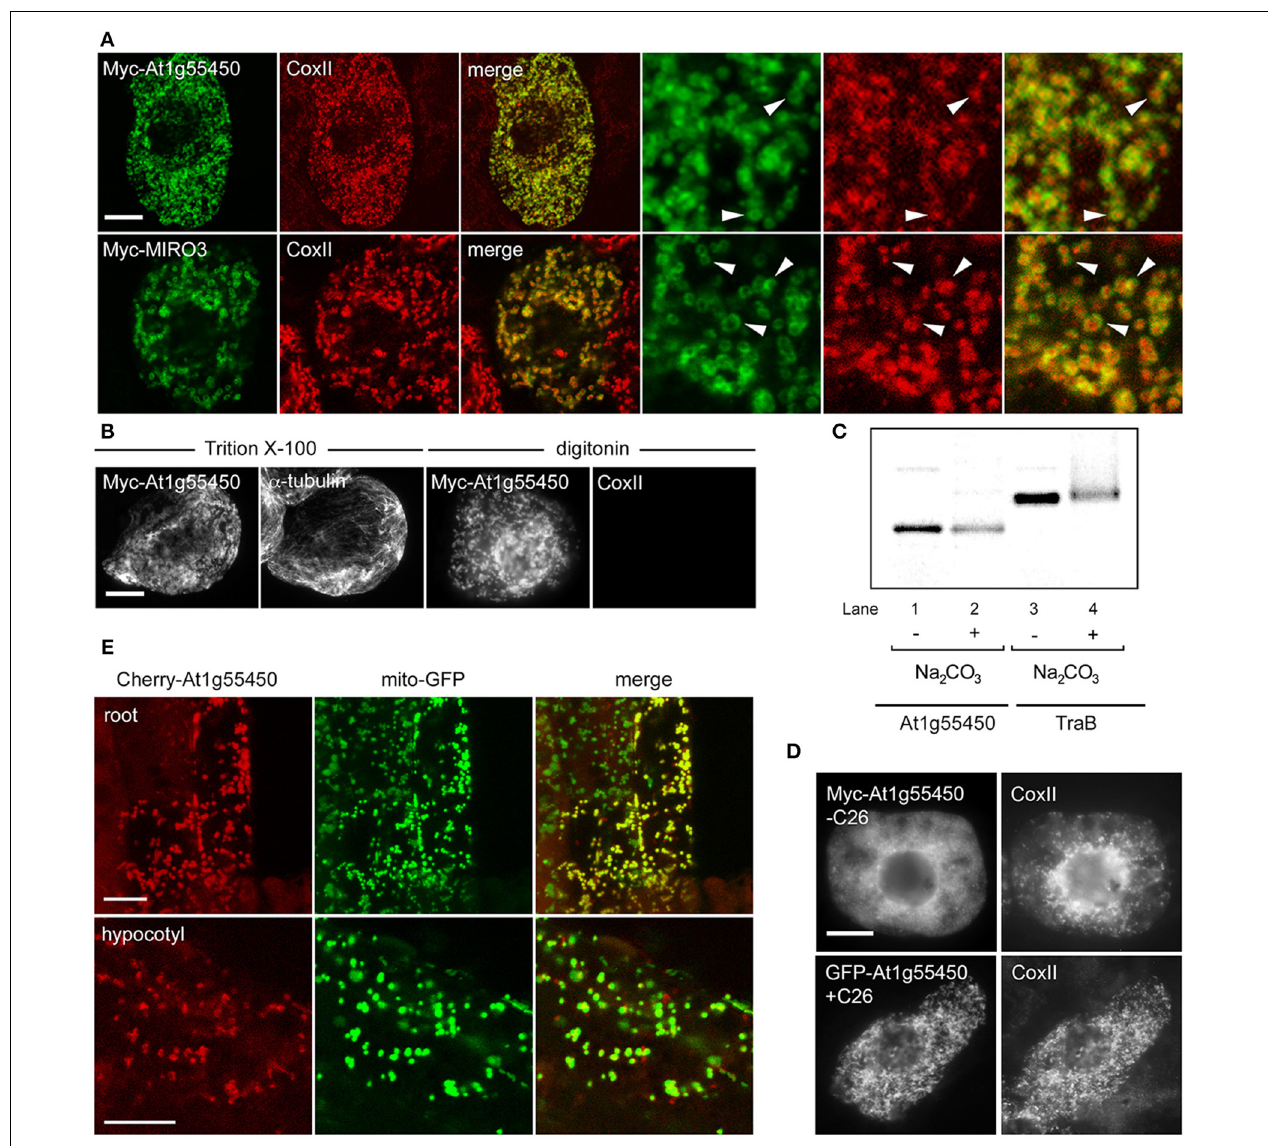
FIGURE 8 | Localization, topology, membrane insertion, and C-terminal targeting-signal analysis of a novel OMM-TA protein, At1g55450. (A) Representative CLSM micrographs illustrating the localization of N-terminal Myc-tagged At1g55450 or MIRO3 to the OMM in BY-2 cells. Cells were processed for immunofluoescence CLSM as in Figure 1 . Shown in the three panels on the right are images corresponding to a portion of the cell at higher magnification. Solid arrowheads indicate examples of the torus-shaped fluorescent structures containing the transiently-expressed protein delineating the spherical structures attributable to endogenous CoxII. (B) Topological mapping of Myc-At1g55450 in differential-permeabilized BY-2 cells. Cells transiently-transformed with N-terminal Myc-tagged At1g55450 were formaldehyde fixed and permeabilized with either Triton X-100 or digitonin, and then cells were processed for immuno-epifluorescence microscopy, as described in Figure 2 . (C) Insertion of At1g55450 into mitochondrial membranes in vitro . Isolated pea mitochondria were incubated with in vitro synthesized Myc-At1g55450 (lanes 1 and 2) or, for comparative purposes, Myc-TraB (lanes 3 and 4), and then